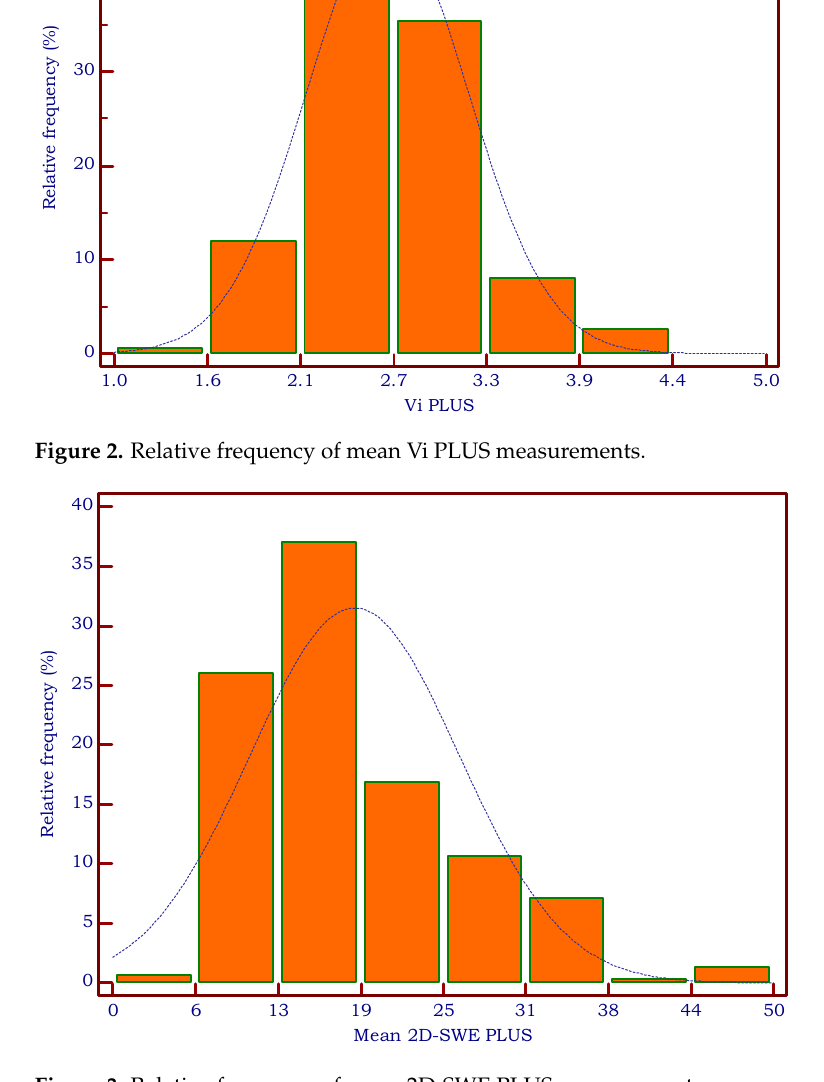
Figure 3. Relative frequency of mean 2D-SWE PLUS measurements.